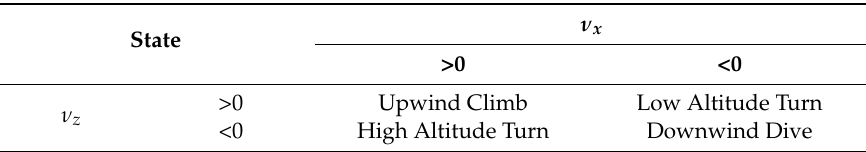
Table 1. Initial entry